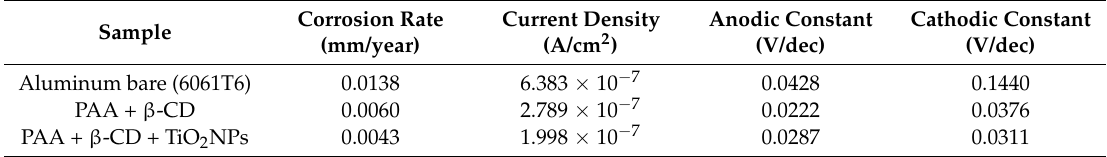
Table 2. The summary of the corrosion data of the following samples after immersion in 3.5 wt % NaCl solution obtained from Tafel polarization measurements.